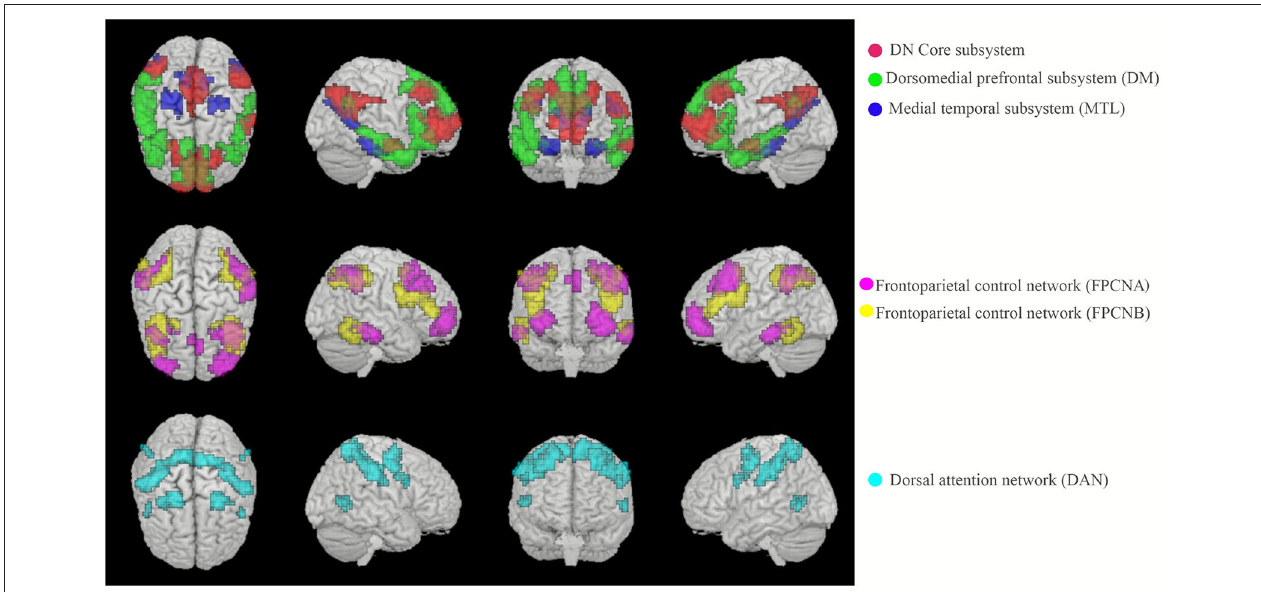
FIGURE 1 | ROIs of the MTL subsystem, DM subsystem, Core, FPCNA subsystem, FPCNB subsystem, and DAN.